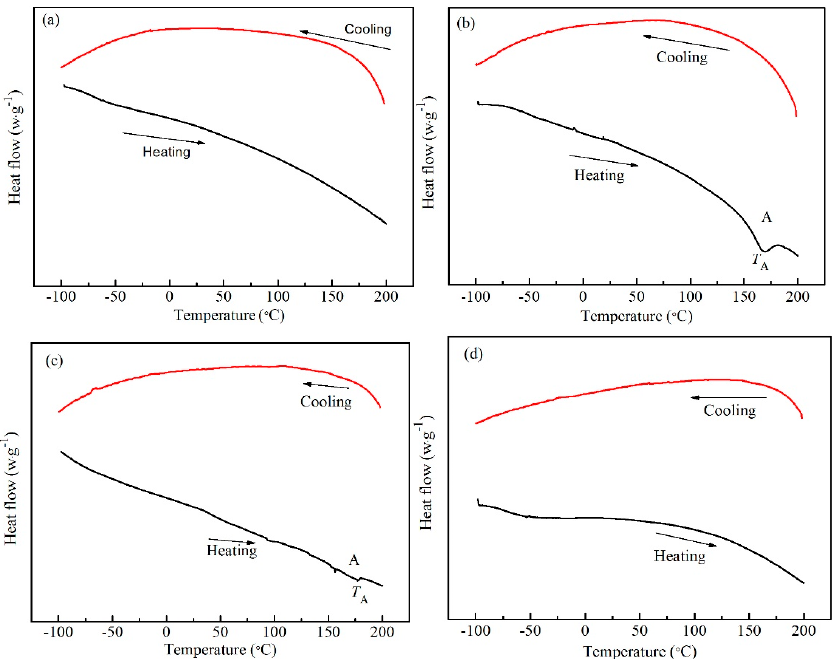
Figure 3. Phase transformation temperature of ( a ) Ti 85 Nb 10 Sn 5 , ( b ) Ti 82 Nb 13 Sn 5 , ( c ) Ti 79 Nb 16 Sn 5 and ( d ) Ti 75 Nb 20 Sn 5 alloys in the DSC curves. ( d ) Ti 75 Nb 20 Sn 5 alloys in the DSC curves.